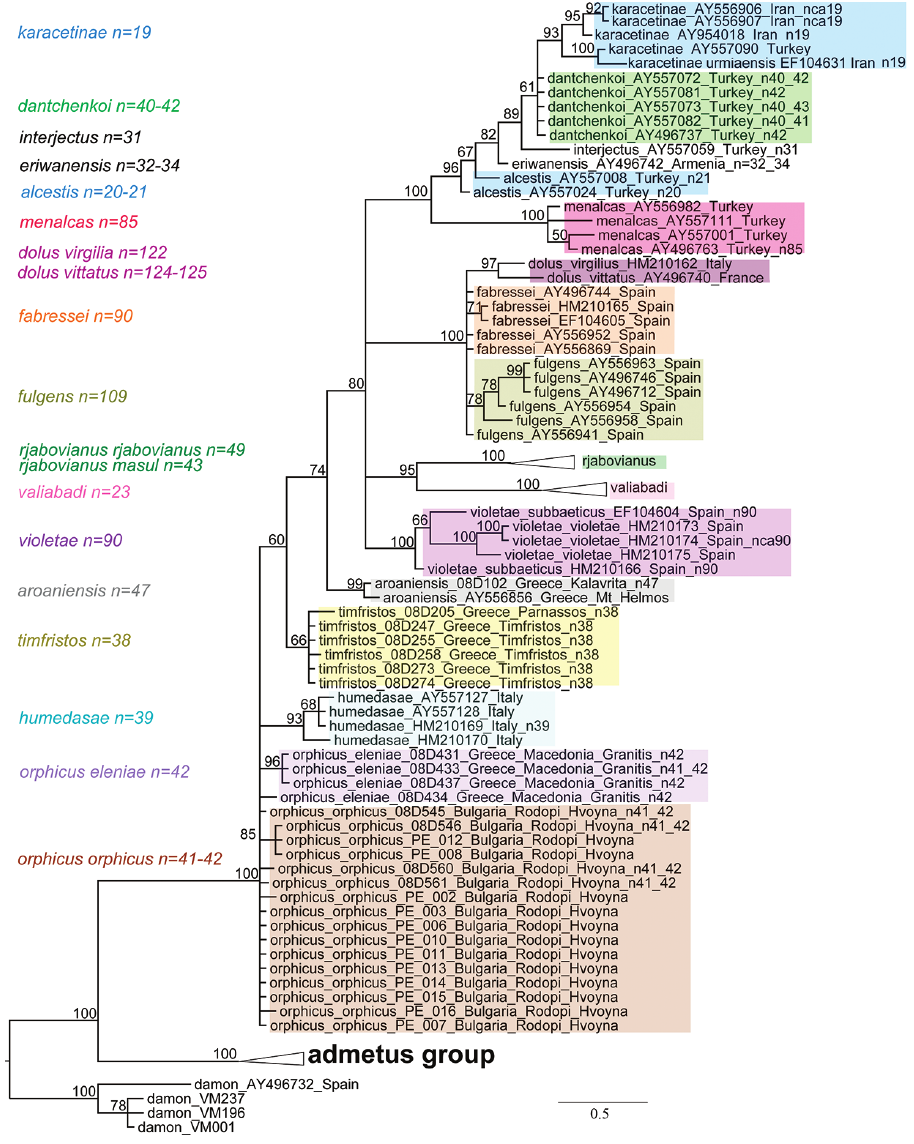
Figure 8. Fragment of the Bayesian tree based on analysis of COI barcodes and focused on details of the P. dolus group. Polyommatus rjabovianus and P. valiabadi clades are not shown in details, for their compo- sition see Lukhtanov et al. (2015a). Numbers at nodes indicate Bayesian posterior